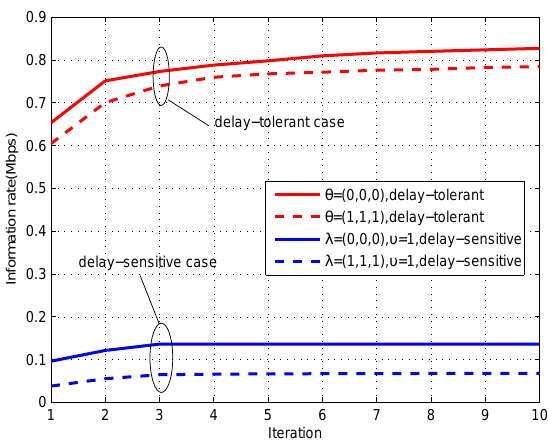
Figure 9. The convergence performance of the proposed algorithm for period T = 60 s.